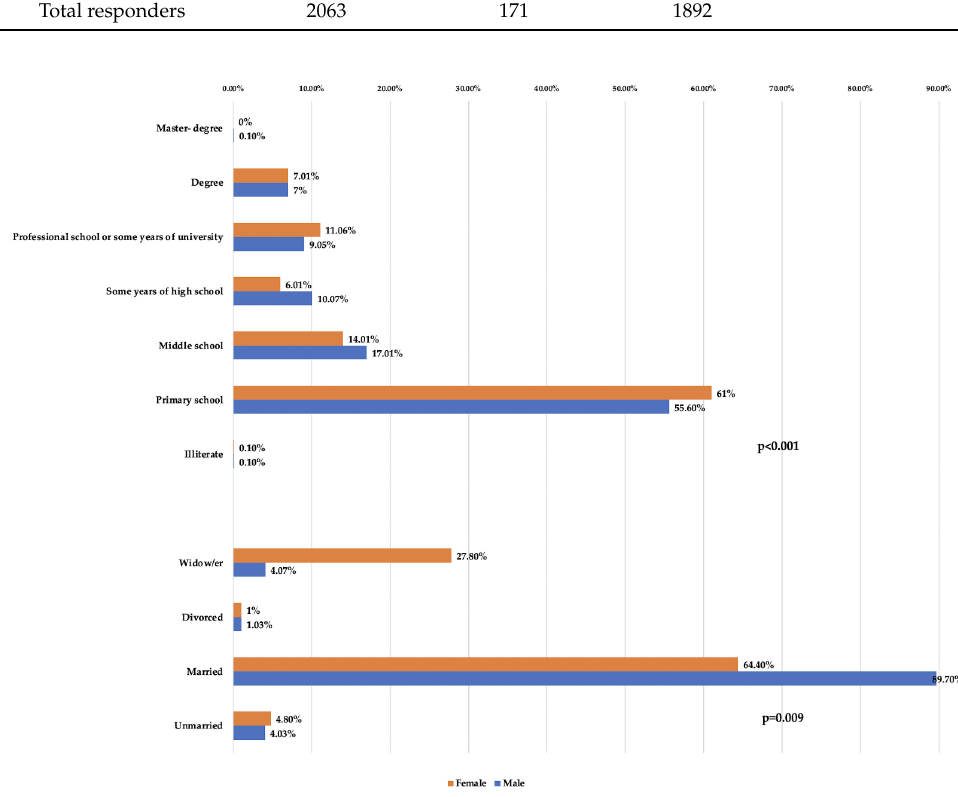
Figure 2. Distribution of socio-demographic variables. Table 2. Comorbidity distribution according to gender. The associations among AAA ≥ 3 cm and the determinants taken into account are reported in Table